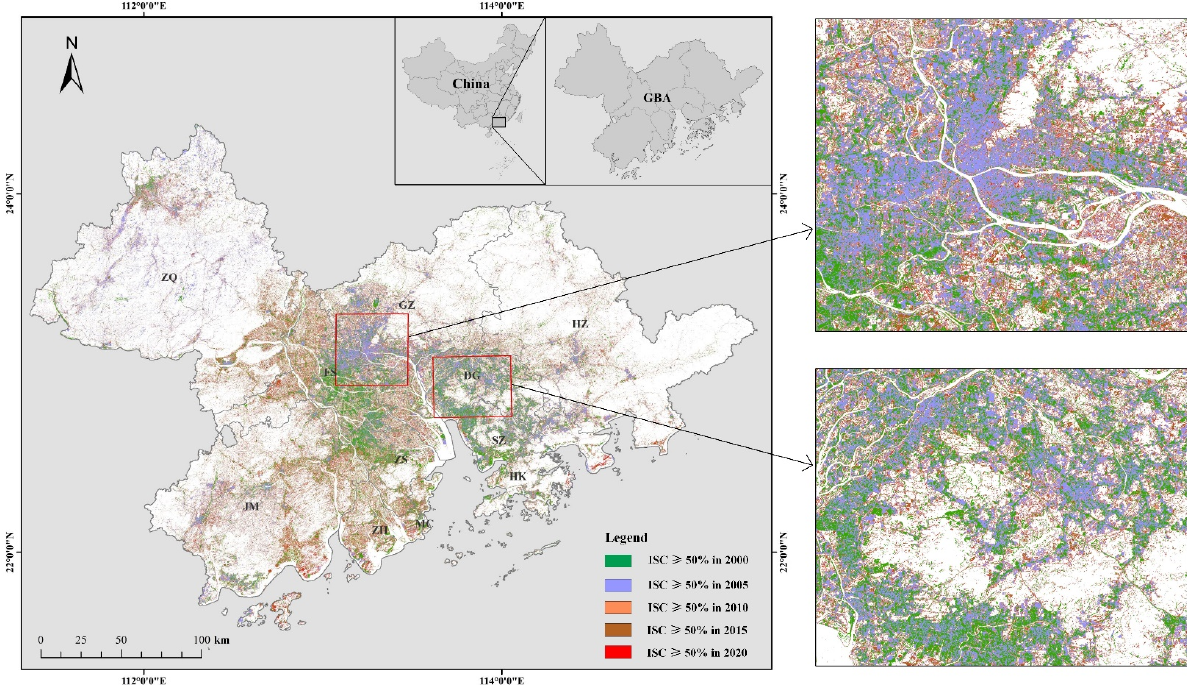
Figure 3. Location of the GBA and the expansion of impervious surface from 2000 to 2020. GBA: Guangdong–Hong Kong–Macau Greater Bay Area, GZ: Guangzhou, SZ: Shenzhen, FS: Foshan, ZS: Zhongshan, ZH: Zhuhai, JM: Jiangmen, ZQ: Zhaoqing, DG: Dongguan, HZ: Huizhou, HK: Hong Kong, MC: Macau, ISC: impervious surface coverage.